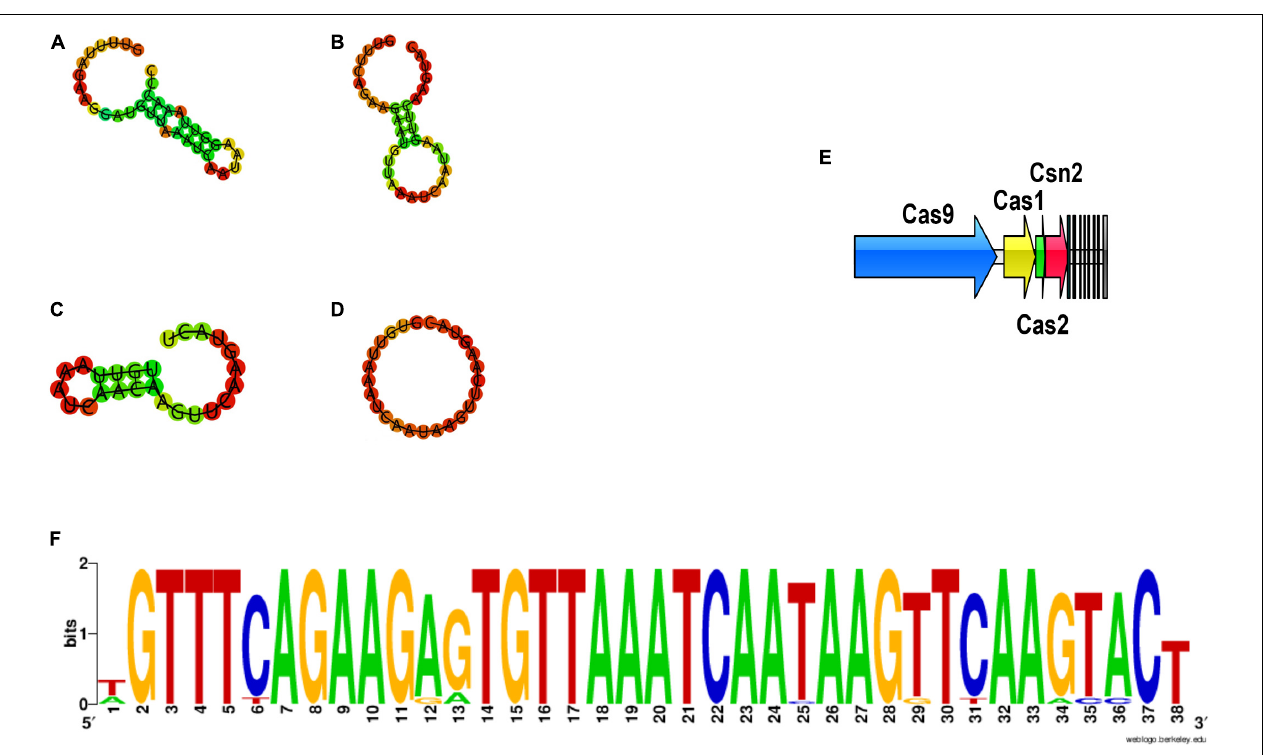
FIGURE 13 | The DR sequences identified in P. pentosaceus. (A) Secondary structure for DR sequences of Pdpen2 (FHNFQ36L4 and HN26M2); (B) Secondary structure for DR sequences of Pdpen3 (JHNZZ2M34, FYNLJ90L2); (C) Secondary structure for DR sequences of Pdpen4 (DYNDL69M8); (D) Secondary structure for consensus of DR sequences of Pdpen1 (the remaining 27 strains). (E) The CRISPR/Cas locus of P. pentosaceus. (F) The Weblogo of DR sequences within the 32 CRISPR loci.